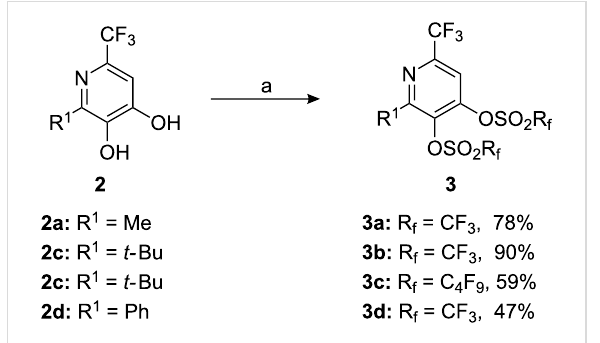
into triflates or nonaflates, respectively (Scheme 2). These substituents represent very good leaving groups for subsequent functionalisations such as palladium-catalyzed C–C cross-coup- ling reactions [26,27]. At first, the pyridindiols 2a and 2c – d were treated with Et 3 N in dichloromethane and an excess of Tf 2 O or Nf 2 O, respectively. This provided bistriflates or bisnonaflates 3a – d as the only products in moderate to very good yields (47–90%). A direct comparison showed that the treatment of 2c with Tf 2 O led to a higher yield than that with Nf 2 O. This may be due to lower steric hindrance in the case of the triflating